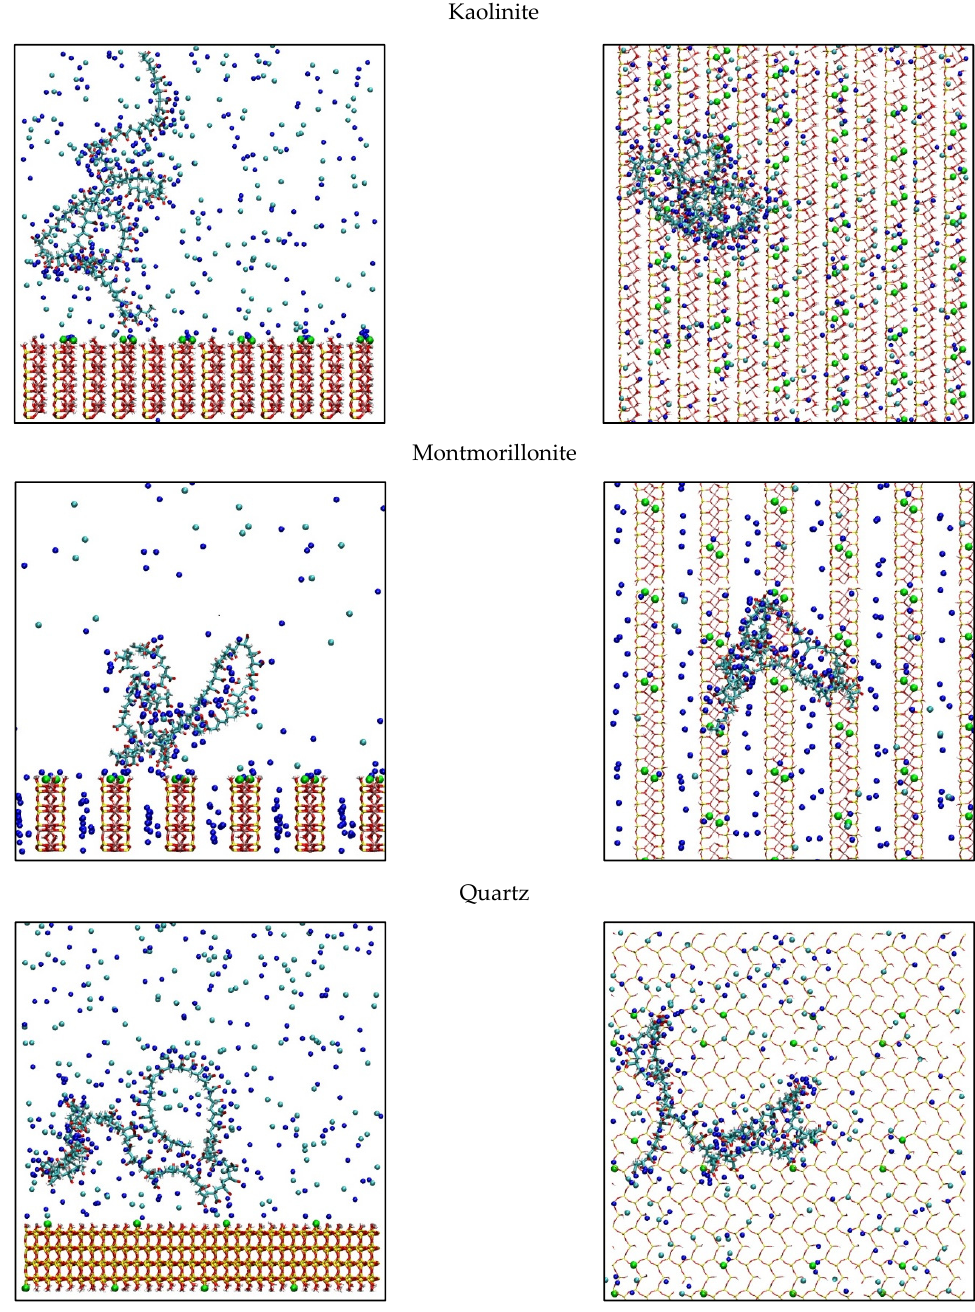
Figure 5. Snapshot of PAA adsorbed configuration onto kaolinite, montmorillonite, and quartz. Green spheres represent charged sites in the mineral surfaces, blue and cyan spheres are the Na + and Cl − ions. Left: side view, Right: top view. Water is not shown for visibility.